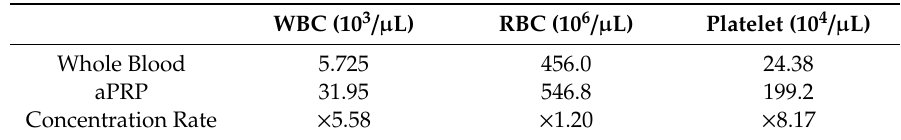
Table 1. Comparison of blood count and concentration: whole blood and activated platelet-rich plasma